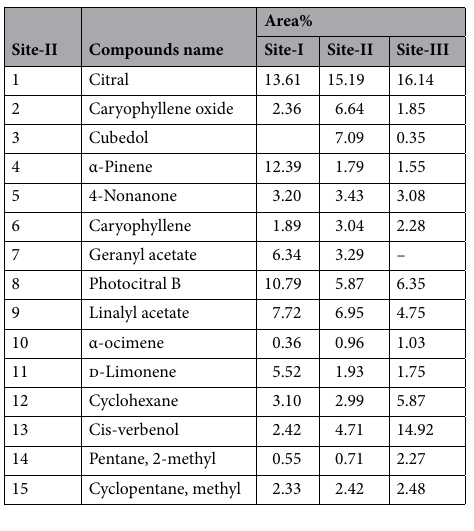
Table 1. Altitudinal disparity in chemical constituents of essential oil of Cymbopogon flexuosus .